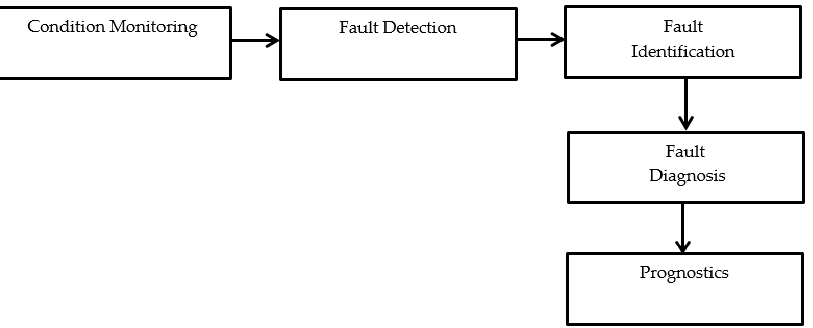
Figure 1. Steps in the process of Condition Monitoring.